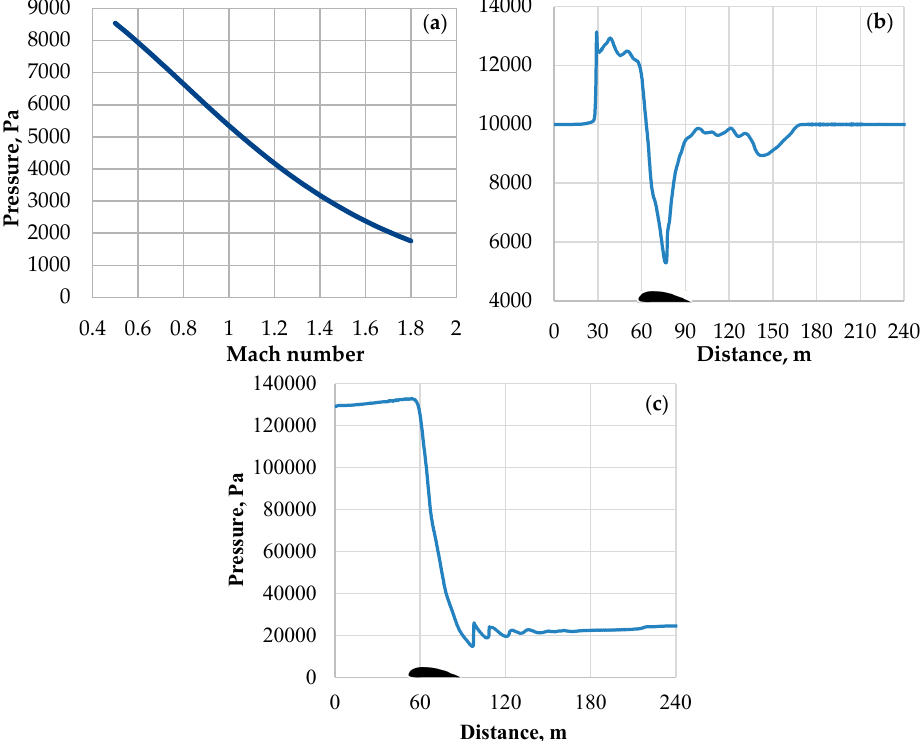
Figure 4. ( a ) Change in the pressure in the bypass in the function of Mach number in the bypass for a fixed free stream pressure 10 kPa and Ma ∞ = 0.5; ( b ) pressure distribution in the tunnel after 0.15 s—the value of pressure is equal to the sonic state pressure; ( c ) pressure distribution after 4.65 s.